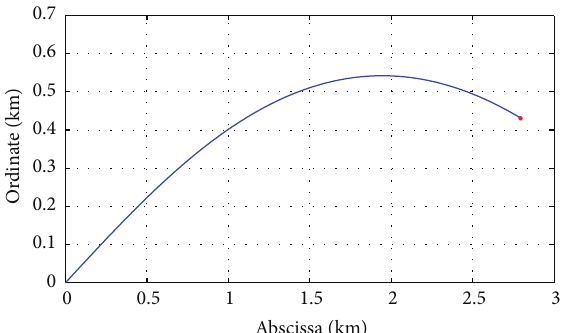
Figure 18: Vehicle B—target engagement scenario.